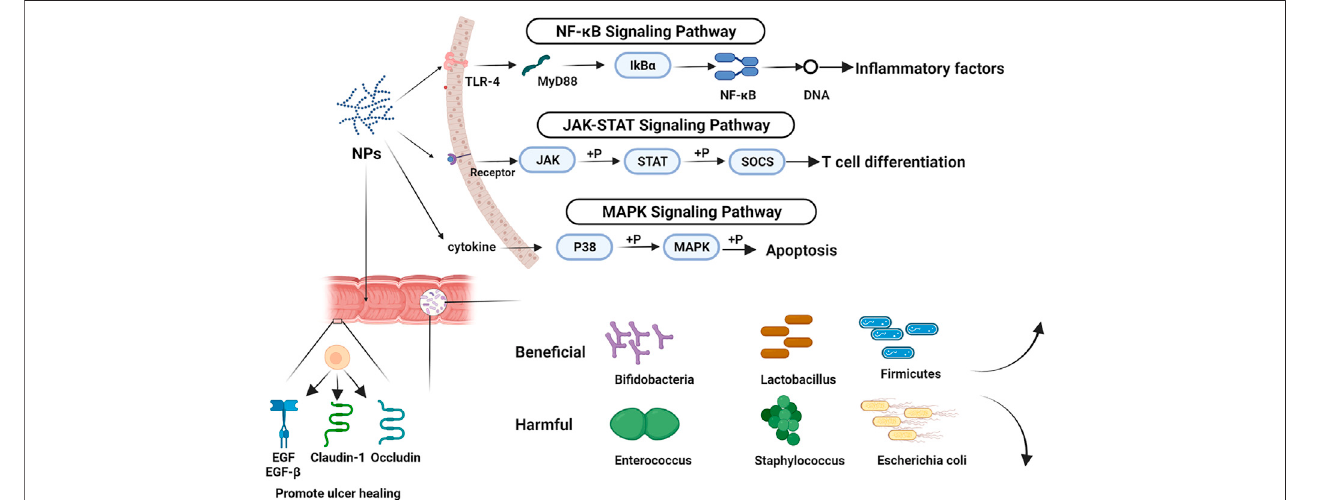
FIGURE 3 | The mechanism of NPs in the treatment of UC. Image was made in BioRender (biorender.com).